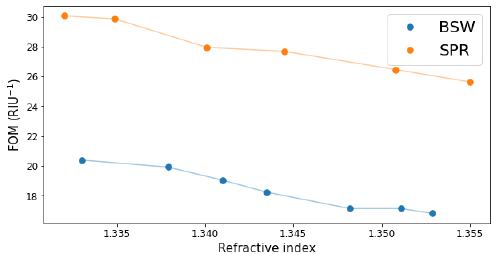
Fig. 4. Experimental values for the Figure of Merit for SPR and